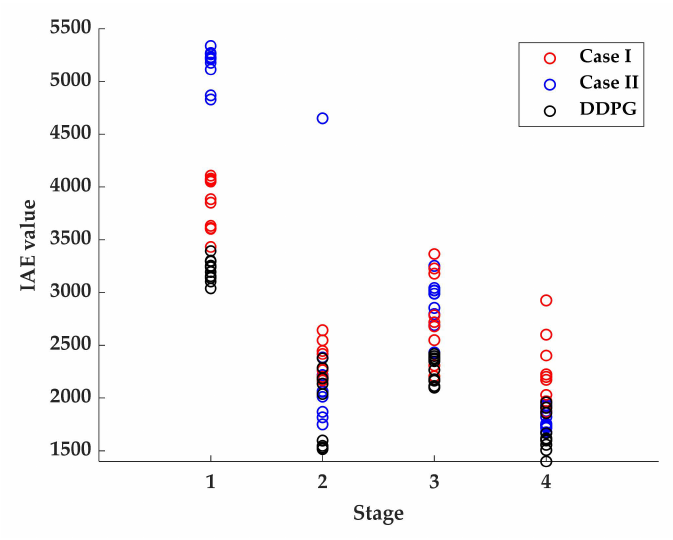
Figure 12. IAE values in each stage.